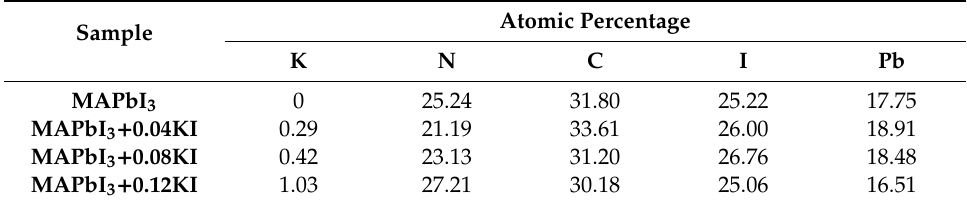
Table 1. EDX element percentages (Atomic %) in the perovskite films with different K + concentrations. Atomic Percentage Atomic Percentage Sample 1 Sample K N K